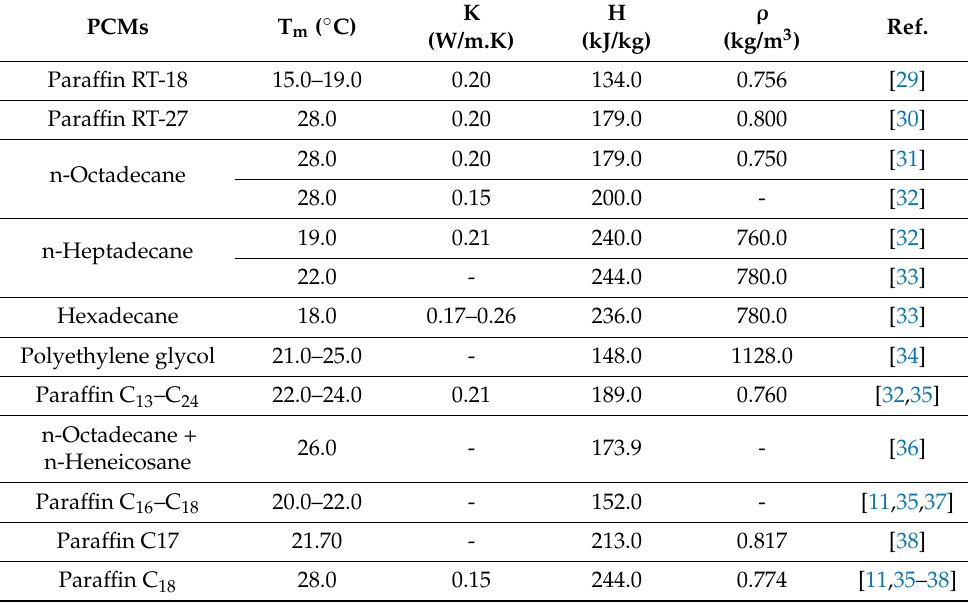
Table 2. Thermo-physical properties of different paraffin